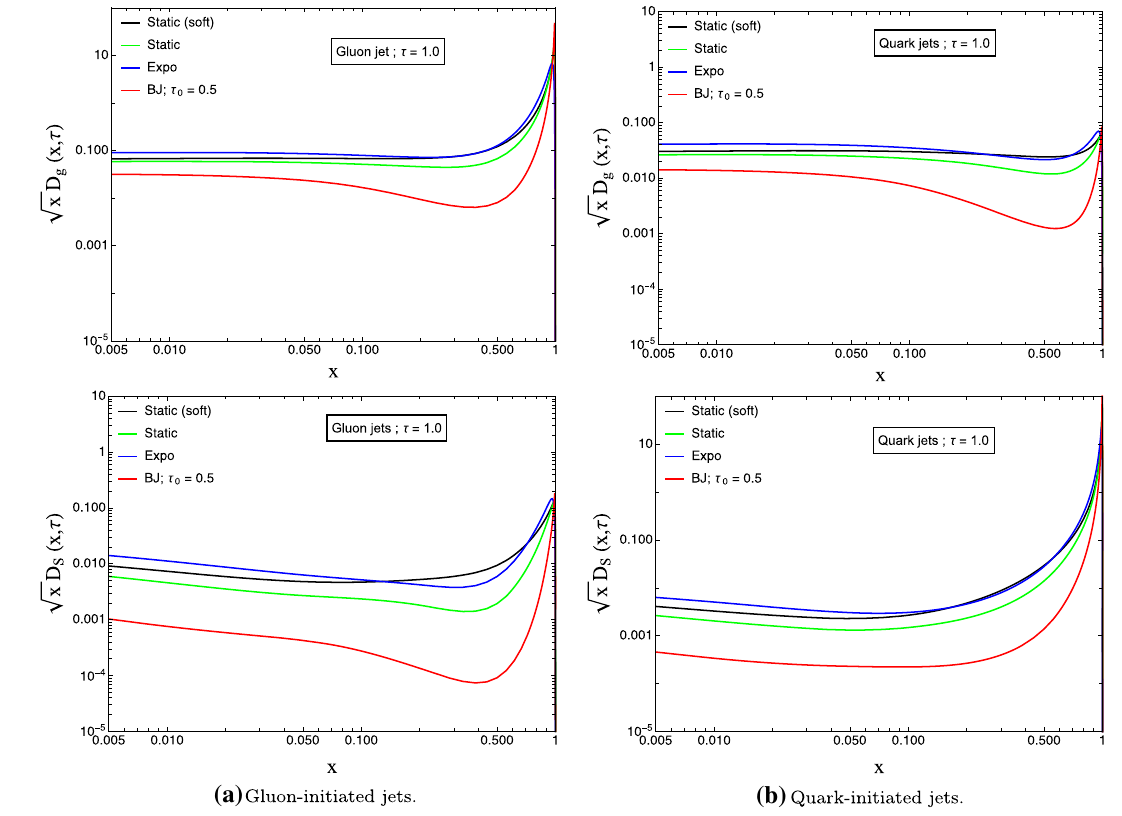
Fig. 1 Evolution of the quark singlet spectra ( D S ) and the gluon spectra ( D g ) for the “gluon initiated” (left panels) and the “quark initiated” jets (right panels) for a particular evolution time τ = 1 . 0 for different medium